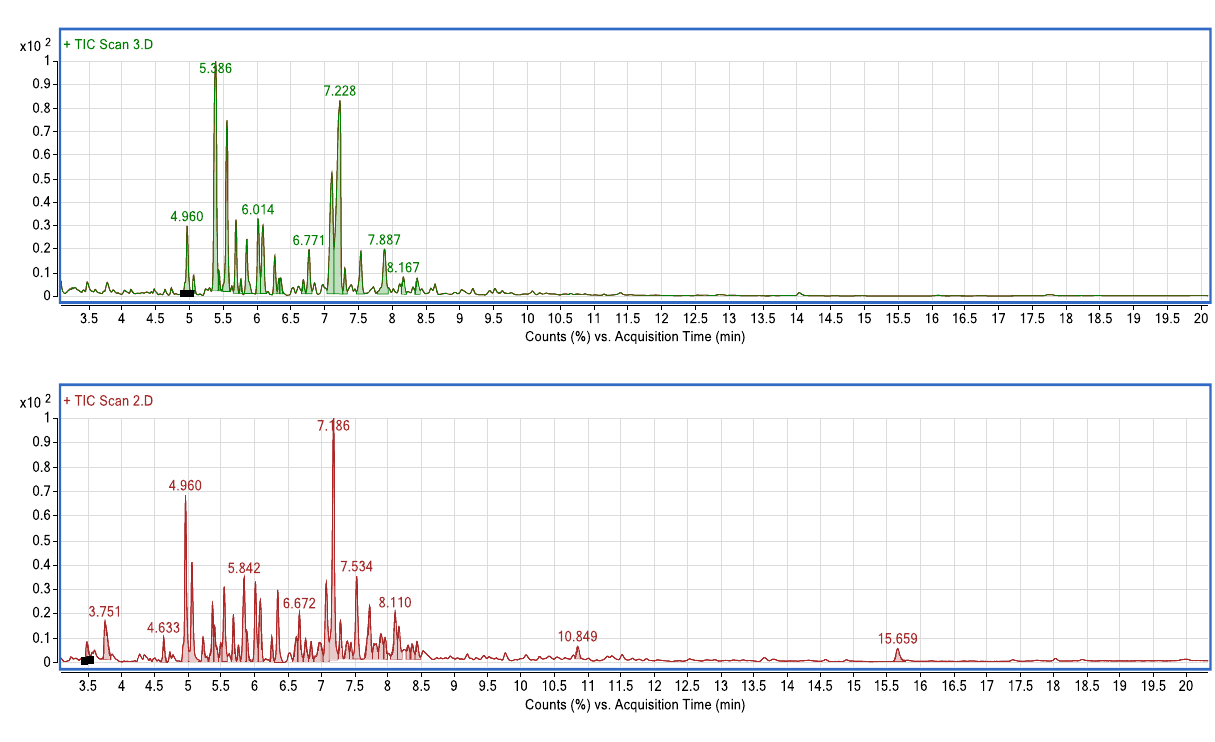
Figure 1: The gas chromatography spectrum of L. umbellata leaves ( up ) and stem ( down )